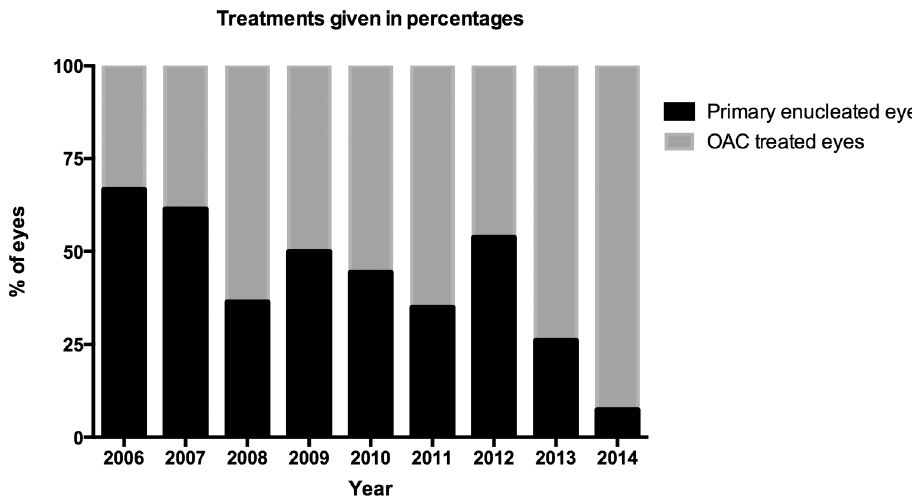
Fig 1. Treatments in unilateral advanced eyes. Stacked bar of graph of the percentage of eyes that were primarily enucleated (black) or treated with OAC (gray) per